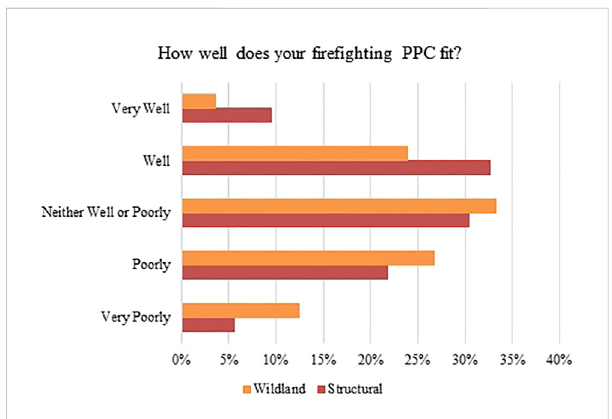
FIGURE 2 Overall fi t ratings of wildland and structural turnout PPC for female fi re fi ghters.